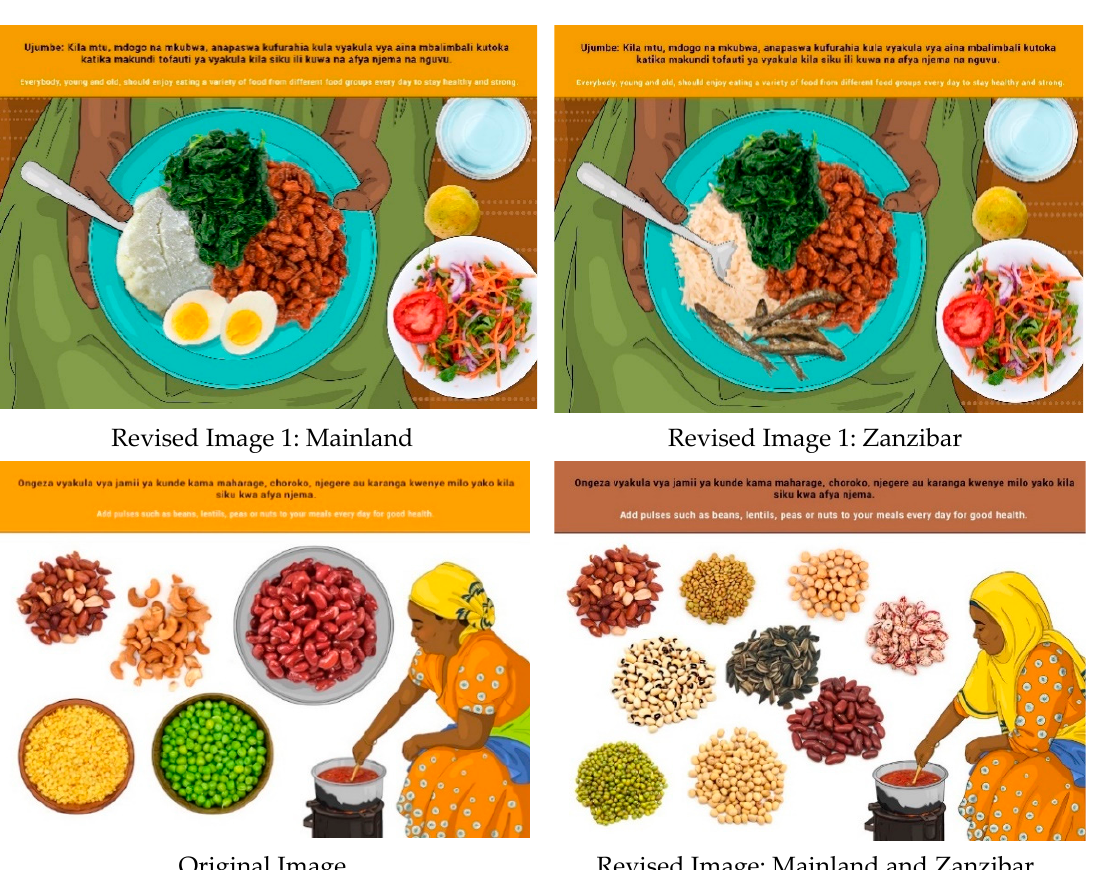
Figure 3. Add pulses such as beans, lentils, peas or nuts to your meals every day for good health. The message and image were well understood, and no changes were suggested.